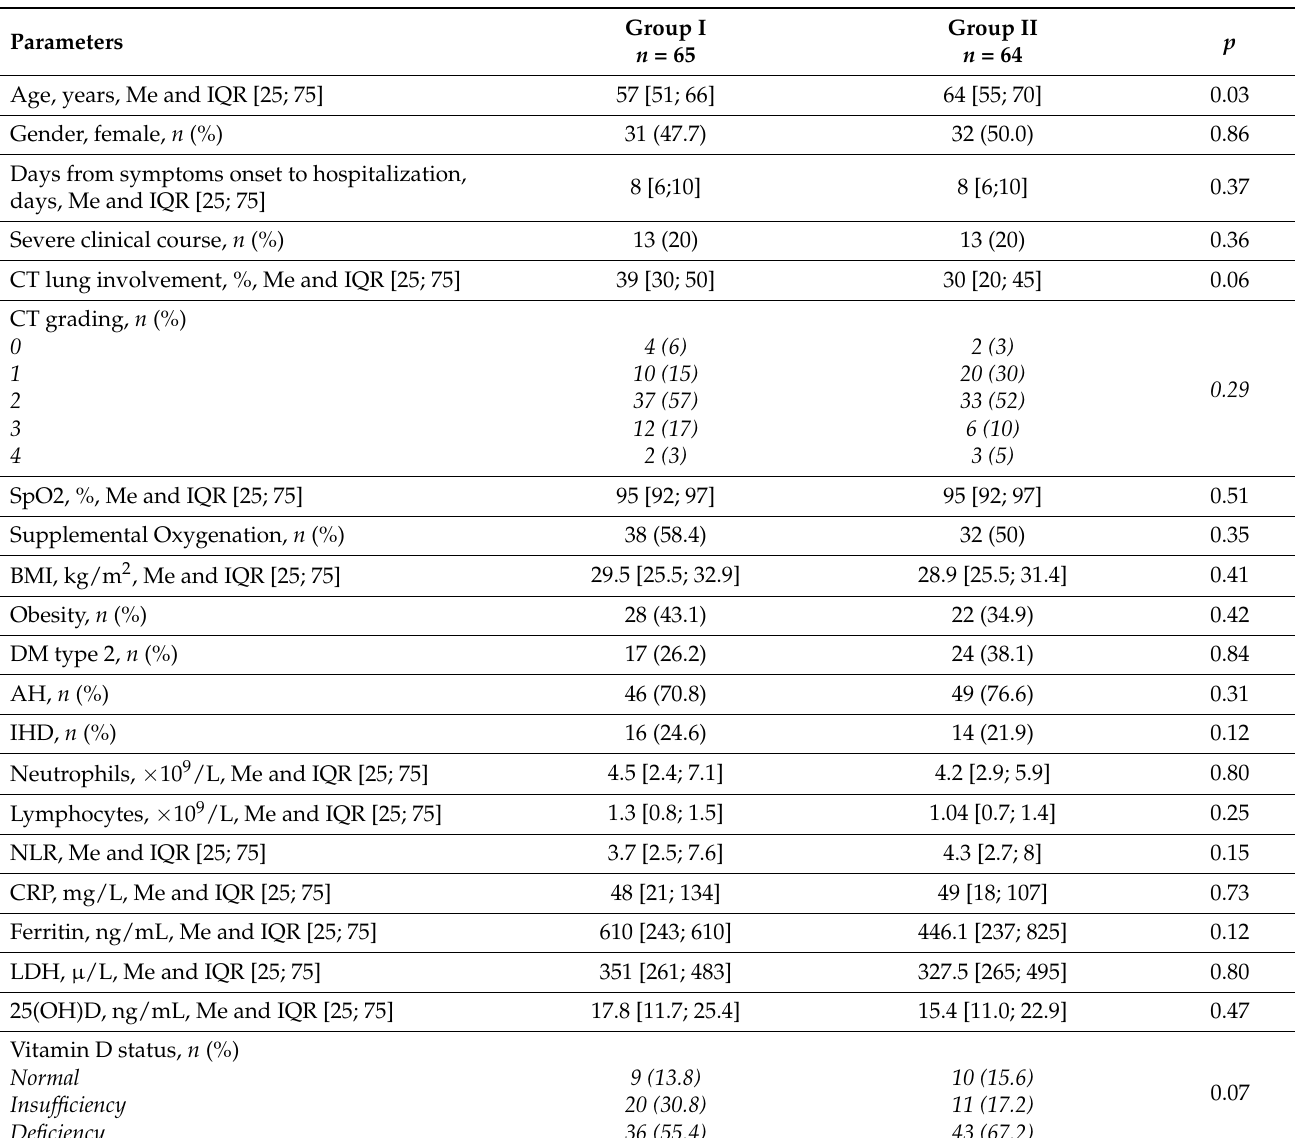
Table 1. Patients’ baseline characteristics ( n =